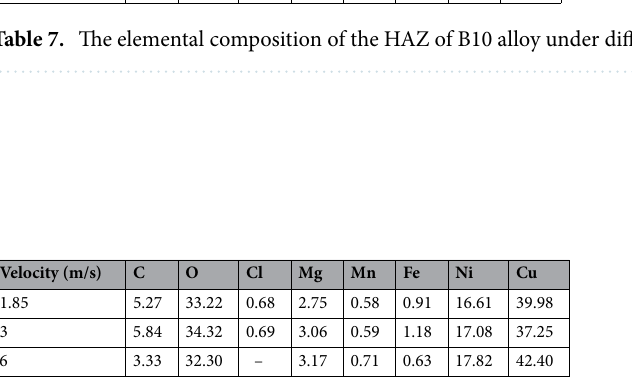
Table 8. The elemental composition of B10 alloy WM under different seawater flow rates.